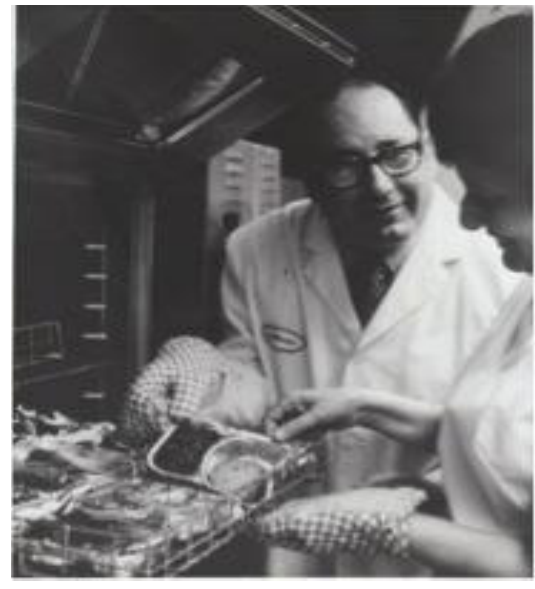
FIGURE 4: AN INDUSTRY CONSULTATION IMAGE COURTESY OF BRIDGEPORT PUBLIC